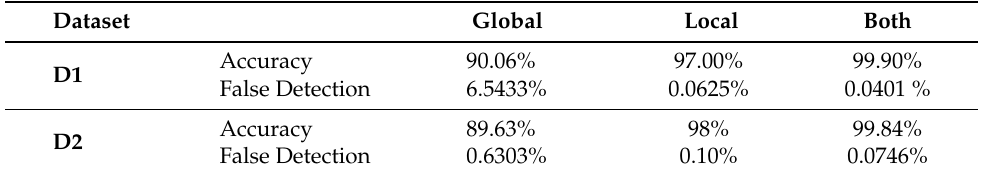
Table 4. Results features comparison for both datasets D1 and D2.